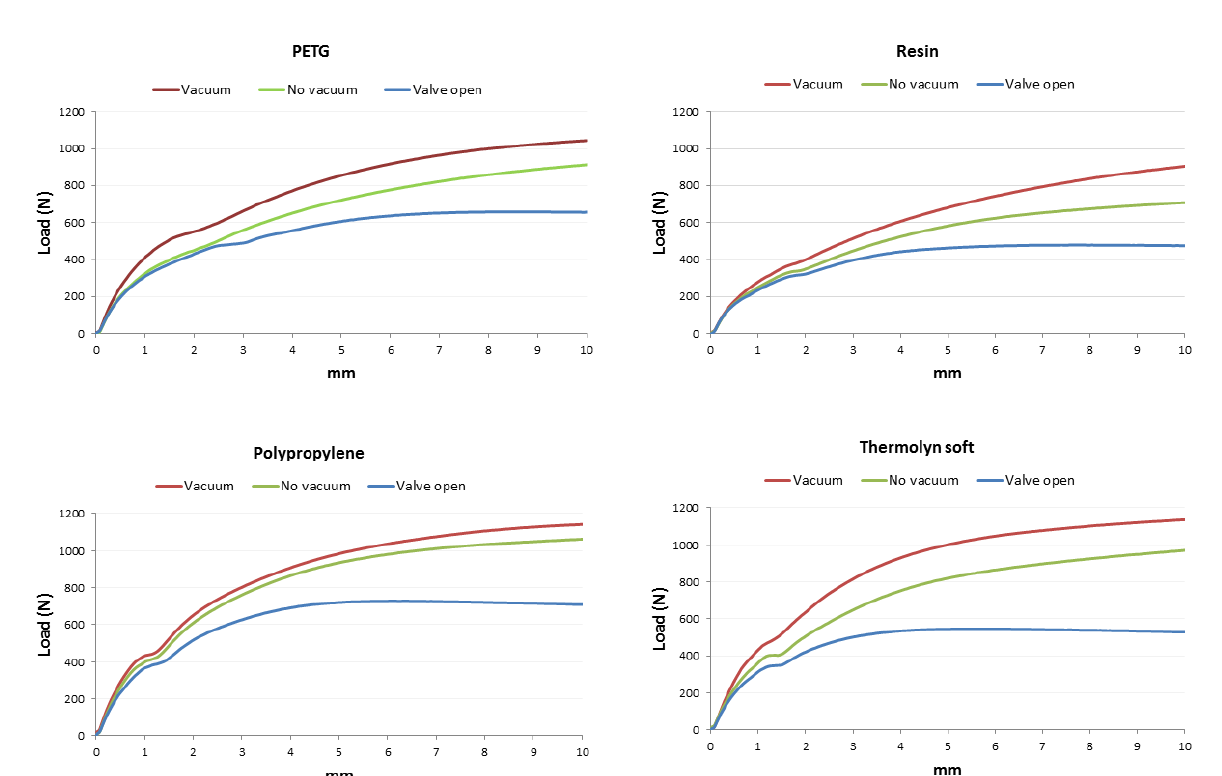
Figure 6: Average displacement (mm) and load (N) in cylindrical socket with Seal-In V high profile.